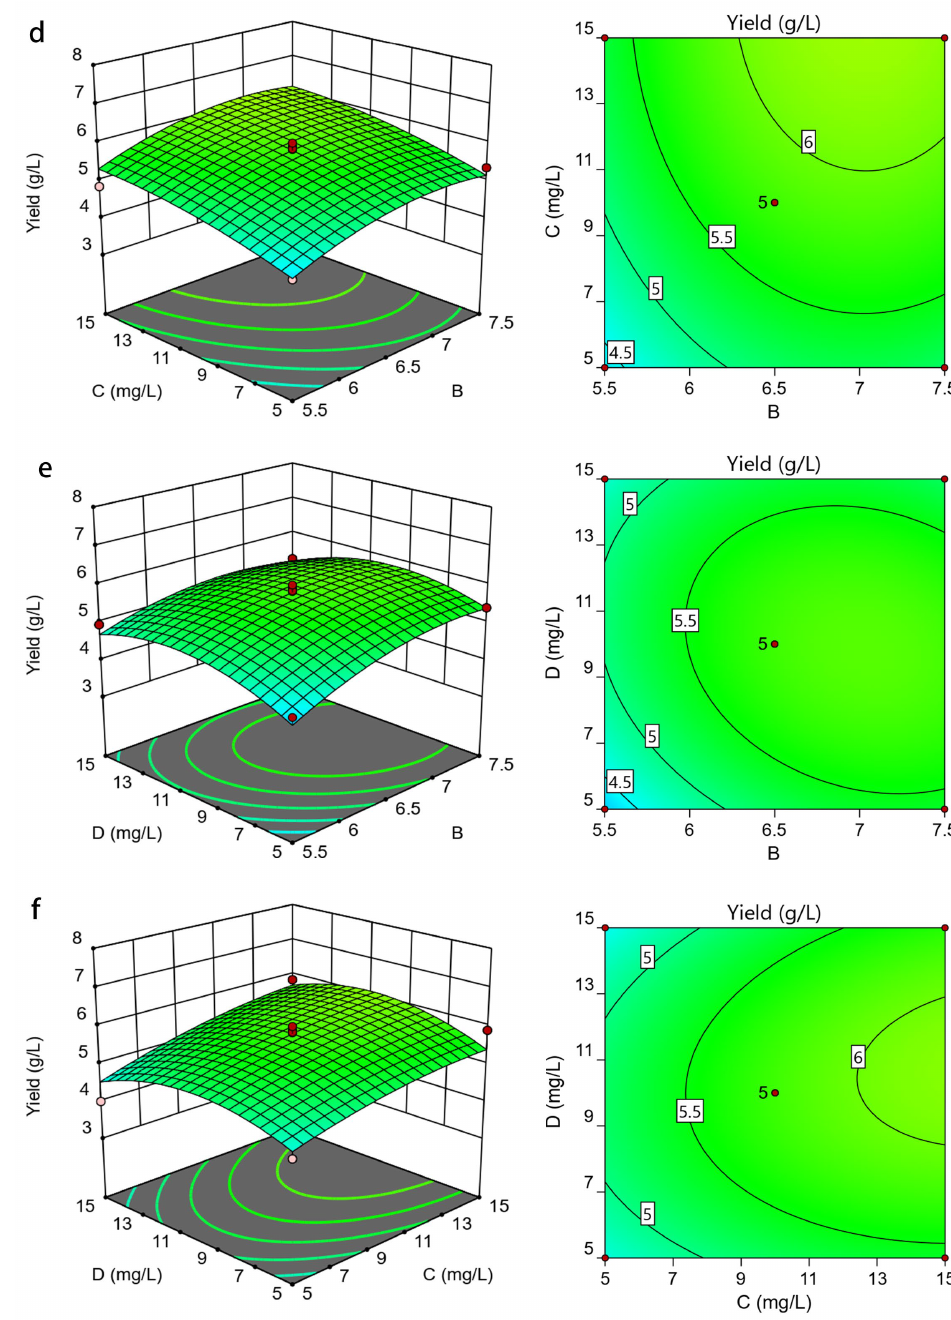
Figure 2. 3D response surface and 2D contour plots. (( a ): glucose concentration and pH; ( b ): glucose concentration and Mn 2+ concentration; ( c ): glucose concentration and Zn 2+ concentration; ( d ): pH and Mn 2+ concentration; ( e ): pH and Zn 2+ concentration; ( f ): Mn 2+ concentration and Zn 2+ concentra- tion).